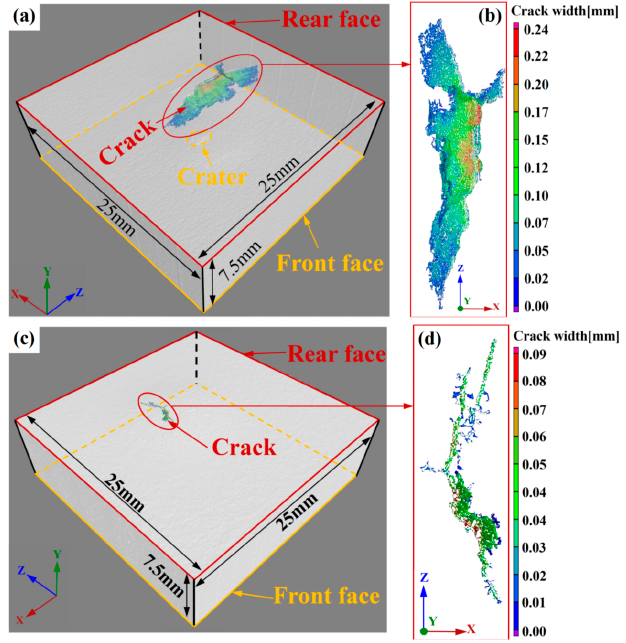
Figure 10. Three-dimensional distribution of cracks, as determined via industrial computer tomography (CT): ( a ) crack distribution in the hot-rolled titanium alloy plate, ( b ) magnified view of the crack in ( a ), ( c ) crack distribution in the heat-treated titanium alloy plate, and ( d ) magnified view of the crack in ( c ).